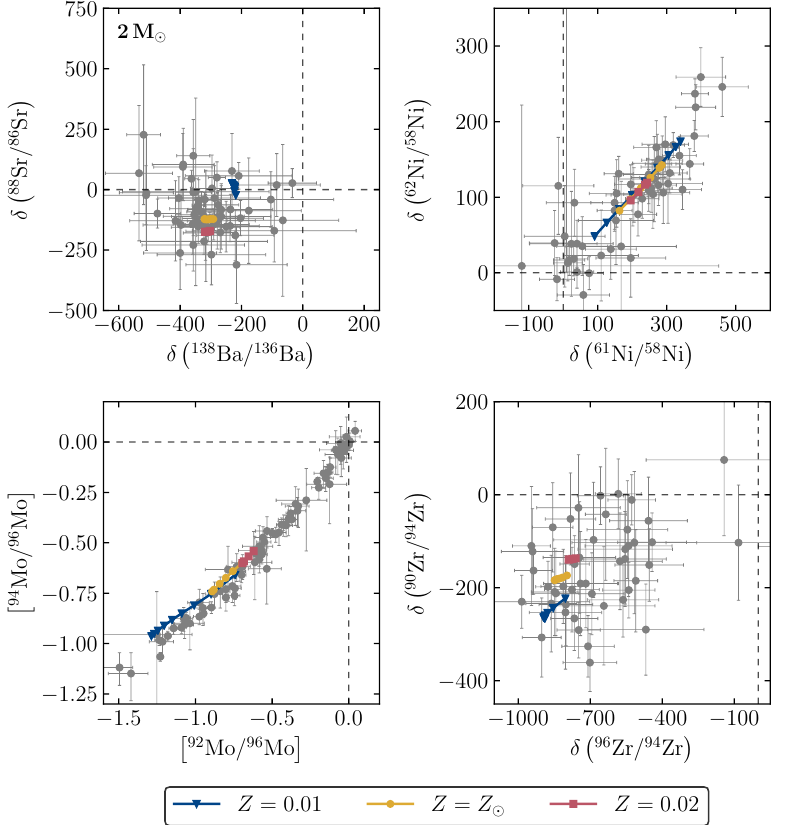
Figure 1. Comparison between FRUITY Magnetic 2 M models at different metallicities and presolar (cid:12) grain isotopic ratios. Grain data are from Nicolussi et al. [157], Barzyk et al. [158], Liu et al. [159], Liu et al. [151,160], Trappitsch et al. [161], Stephan et al. [162], Stephan et al.